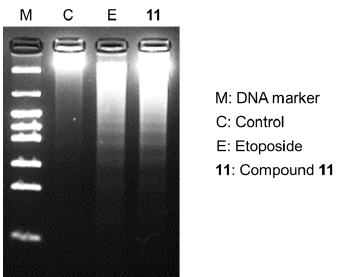
Figure 4. Induction of DNA fragmentation by 11 in HL-60 cells. HL-60 cells were incubated at 37 °C for 20 h with 10 µM of 11 or 15 µM of etoposide (E). DNA was then extracted and subjected to agarose gel electrophoresis.